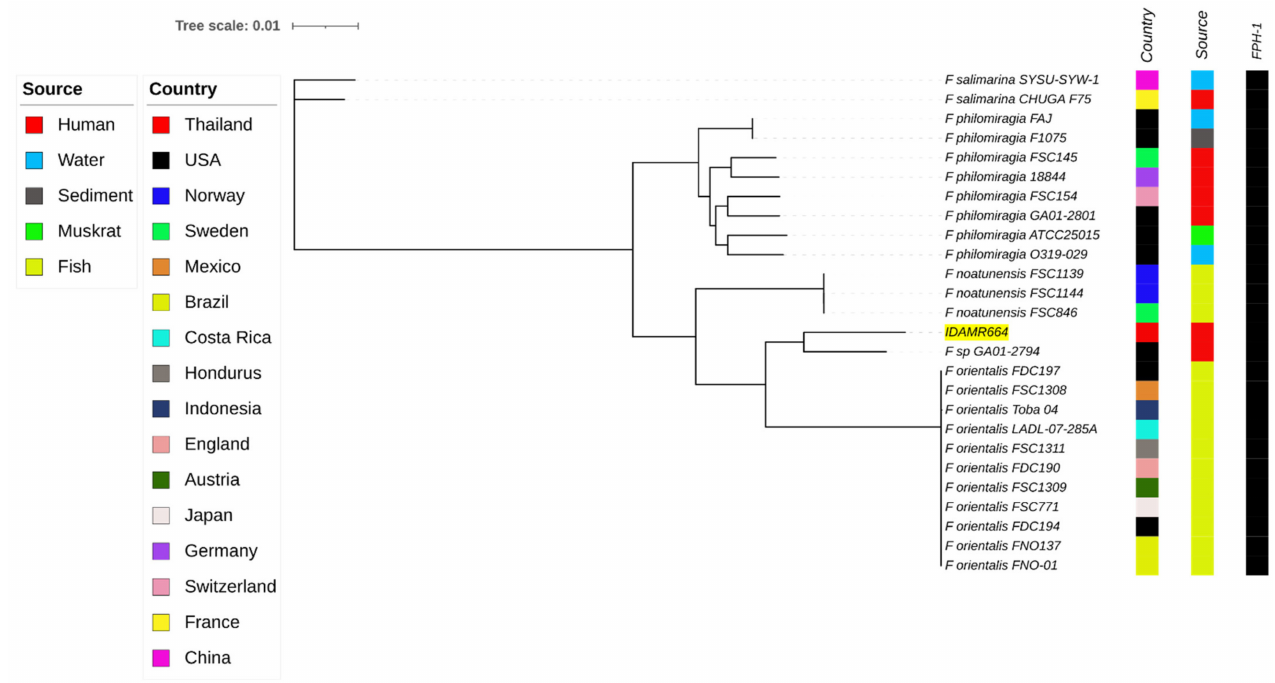
Figure 1. Whole-genome phylogeny analysis of Francisella clade-2 species generated using CSI phylogeny and visualized with an interactive life tool tree. Francisella strain IDAMR664 in this study is highlighted in yellow. Presentation of the antimicrobial-resistance gene, FPH-1, is shown by filled